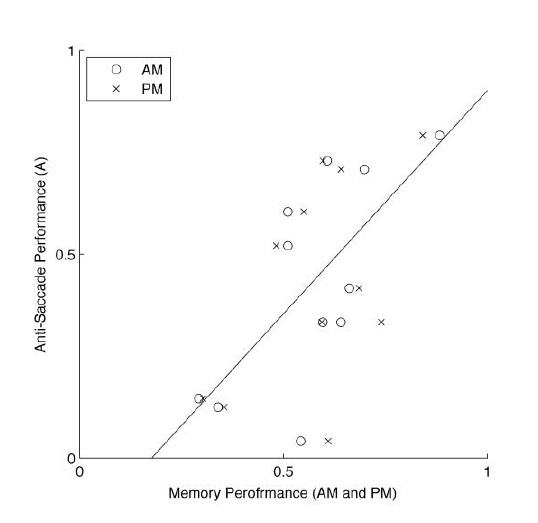
Figure 4. The subjects, who are performing well in the anti- saccade task, tend to do well in the working memory task, too. The correlation coefficient between A and AM performances was 0.69, and 0.54, between A and PM. The best-fit line be- tween A and AM is